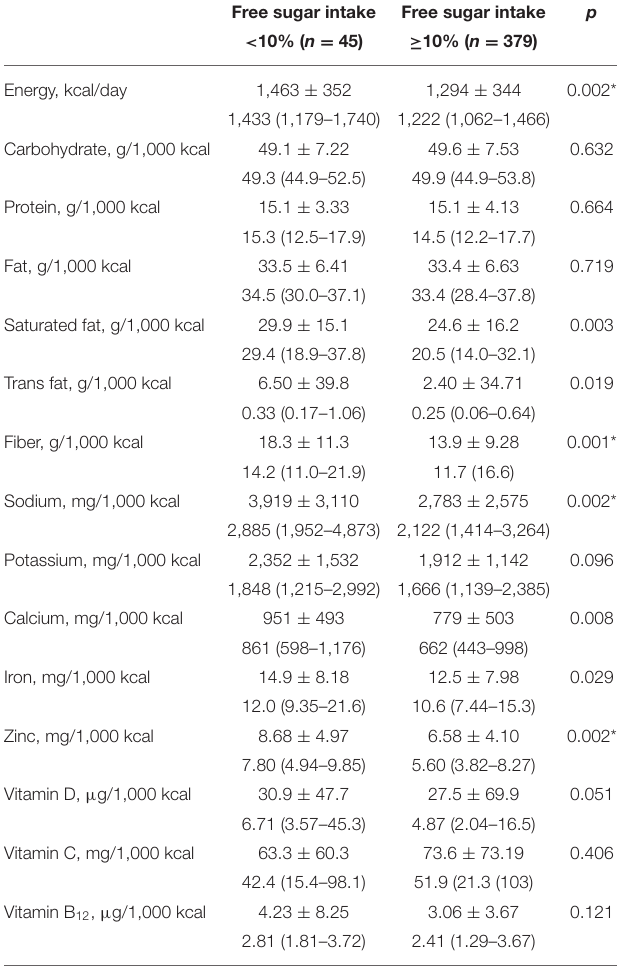
TABLE 2 | Nutrient intake of children stratified by percent of free sugar intake. Free sugar